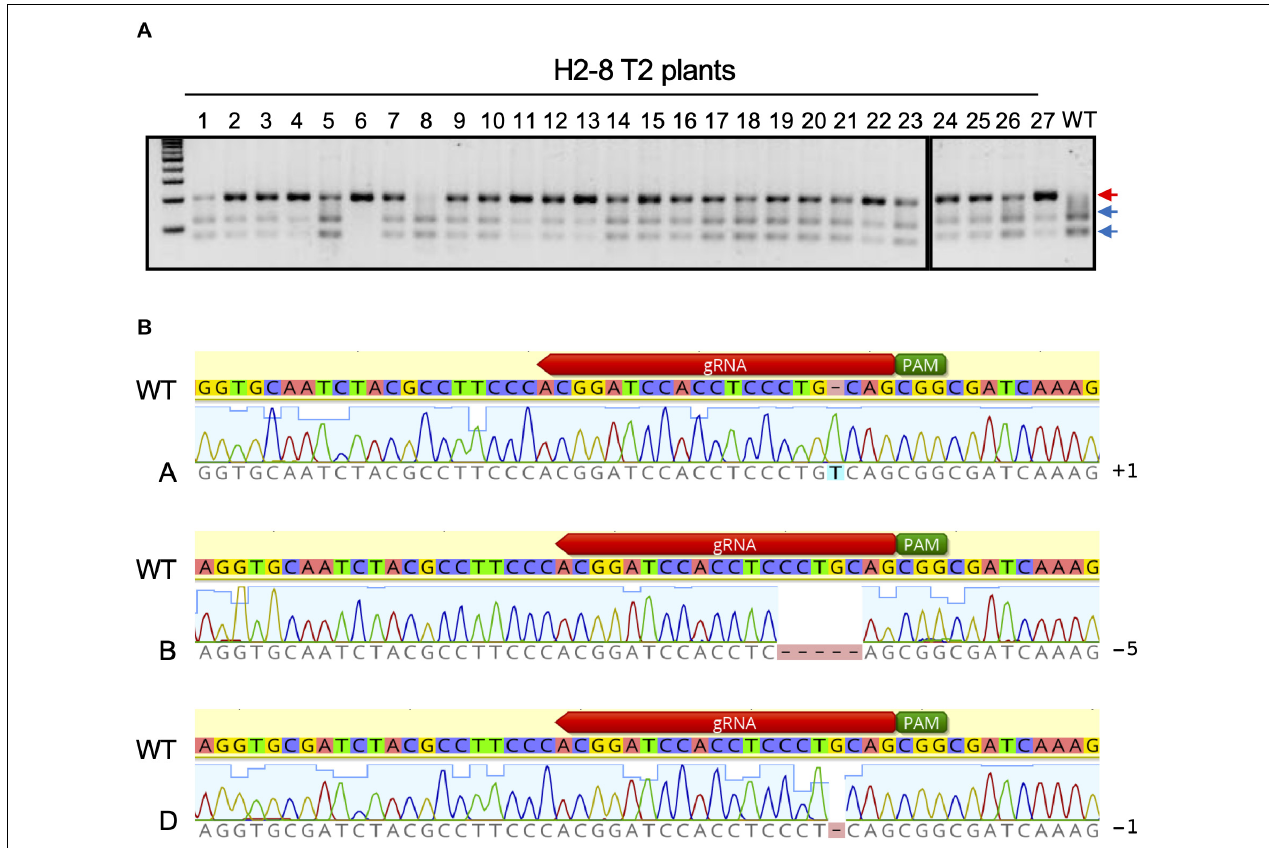
FIGURE 3 | Isolation of a triple homozygous taqsd1 plant from H2-8 plant progeny. (A) Genotyping of H2-8 plant progeny. The genomic fragments are amplified by A, B and D genome specific primer sets, and the PCR products are digested by Pst I restriction enzyme. Red and blue arrows indicate the sizes of undigested and digested bands after Pst I treatment, respectively. A 100 bp DNA ladder was used. (B) The sequences of the TaQsd1 target region of H2-8-6.